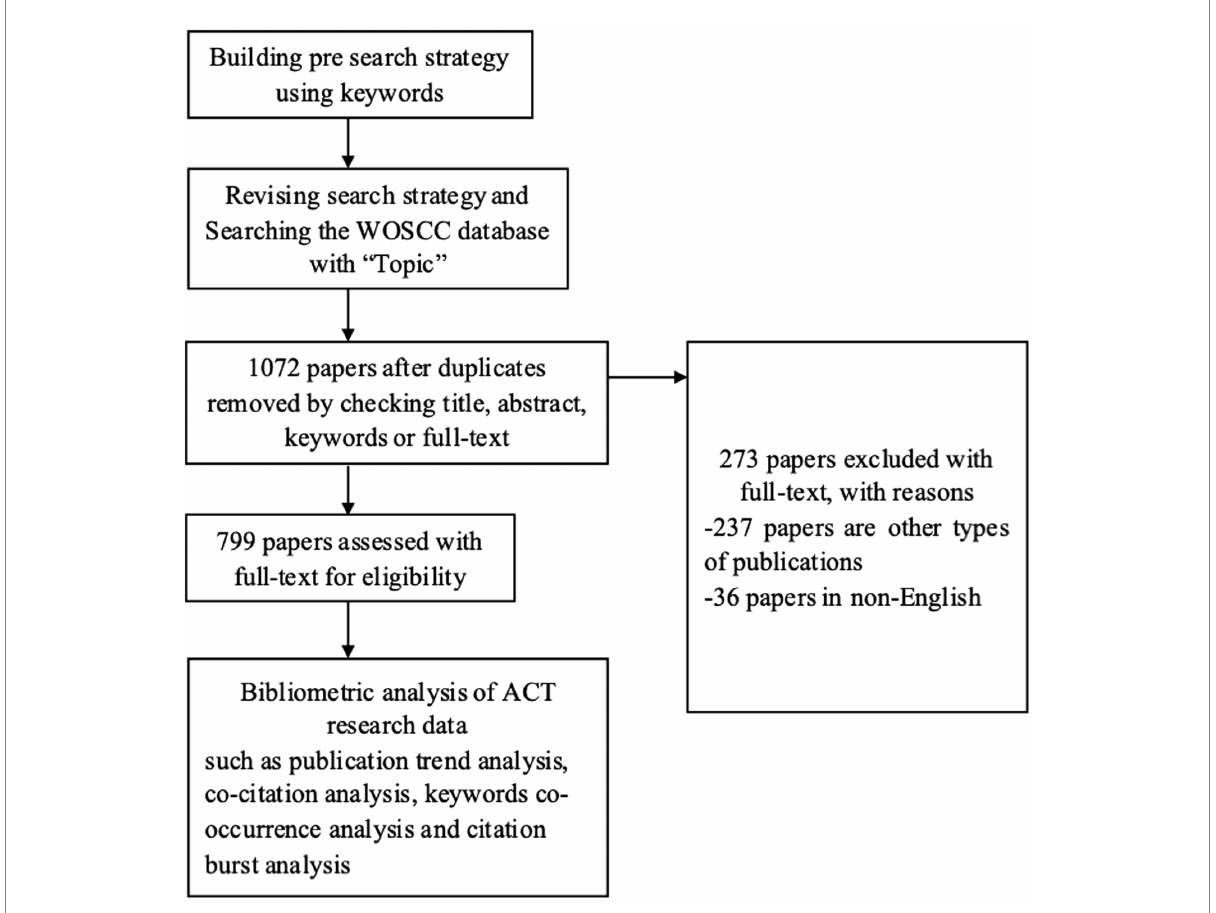
FIGURE 1 Data search and selection process in ACT research (based on the PRISMA 2020